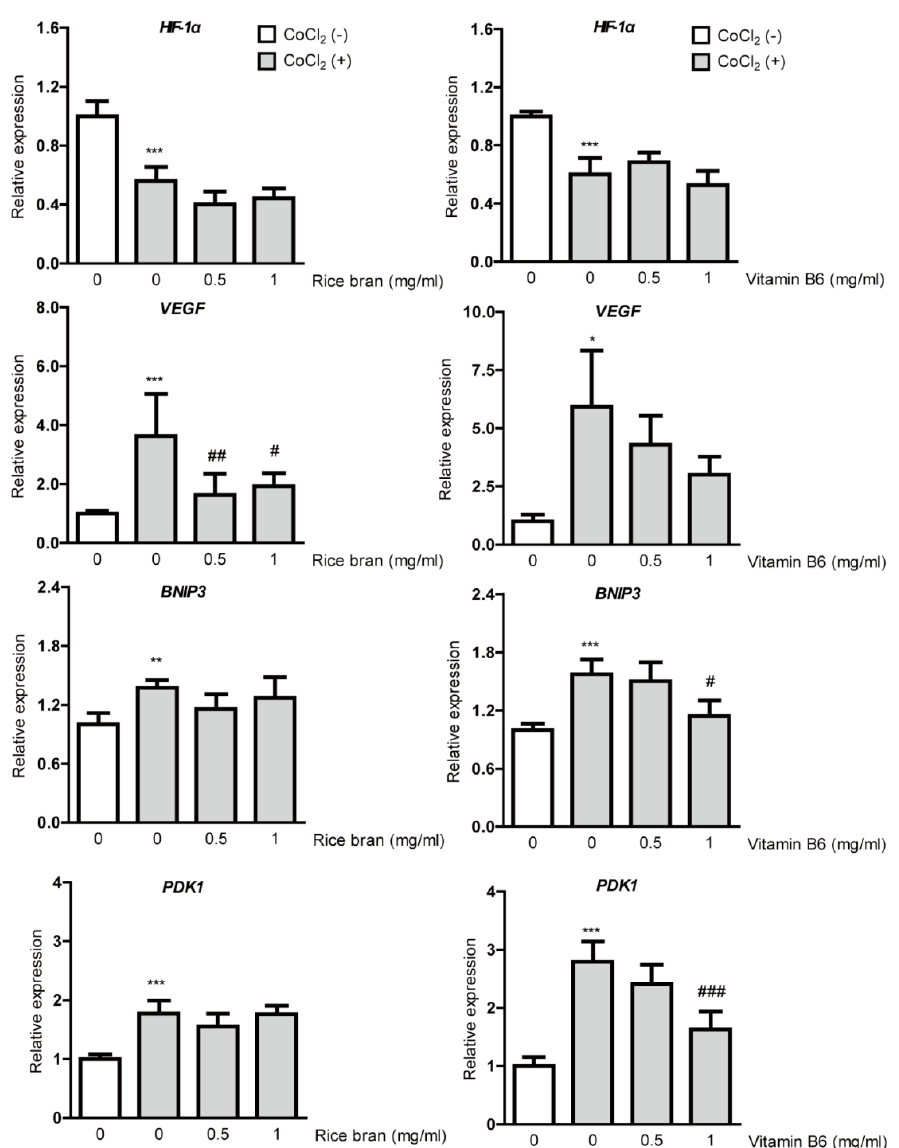
Figure 3. Suppression of hypoxia ‐ responsive gene expressions by rice bran and vitamin B6.